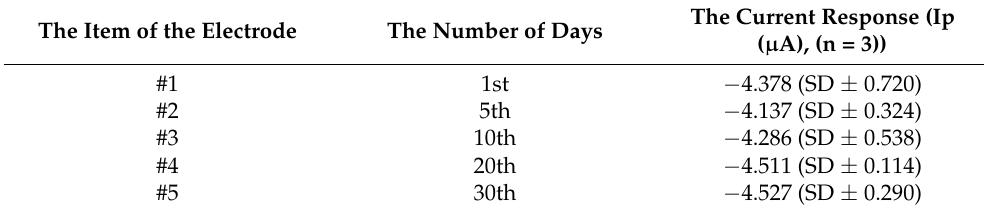
Table 3. The stability of MB / GP modified electrode .